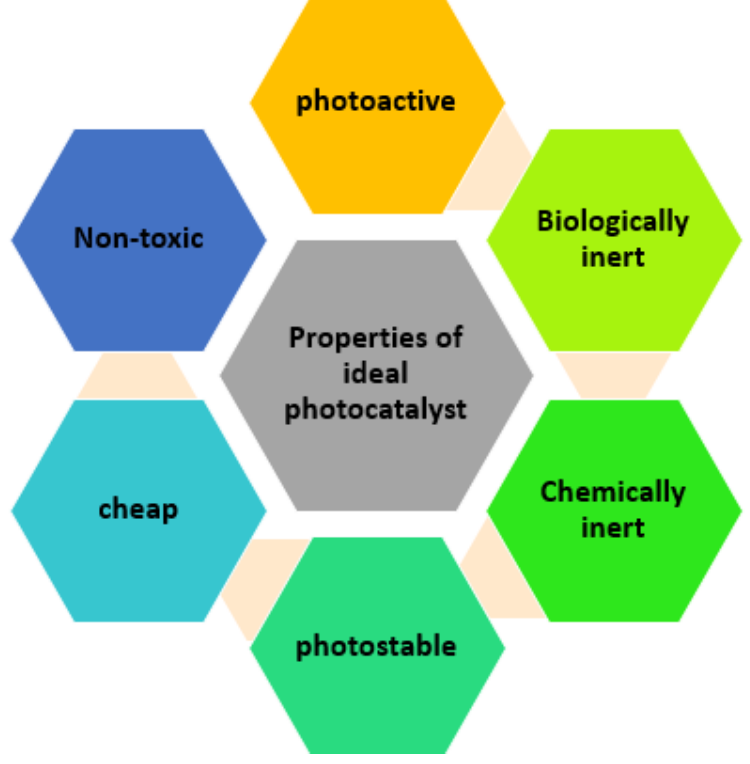
Figure 6. Properties of ideal photocatalysts.